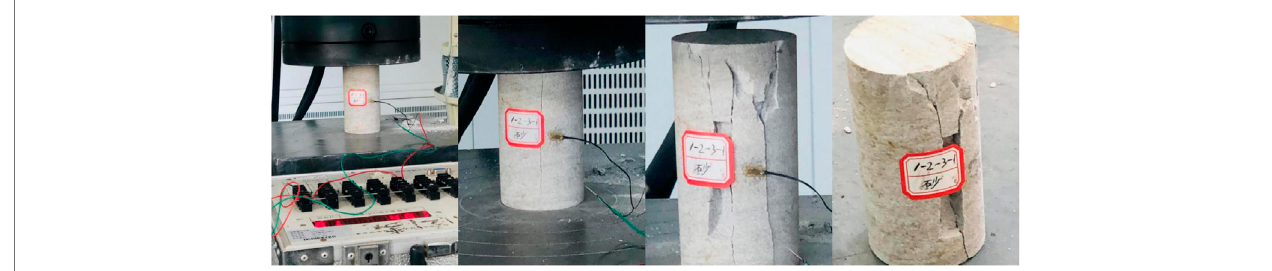
FIGURE 1 | Compressive failure process of the rock.